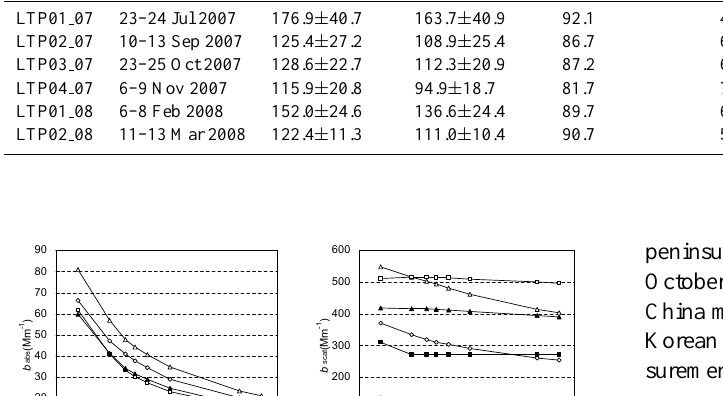
Table 5. Summary of aerosol physical and optical properties measured during different long-range transport pollution (LTP) periods. Category